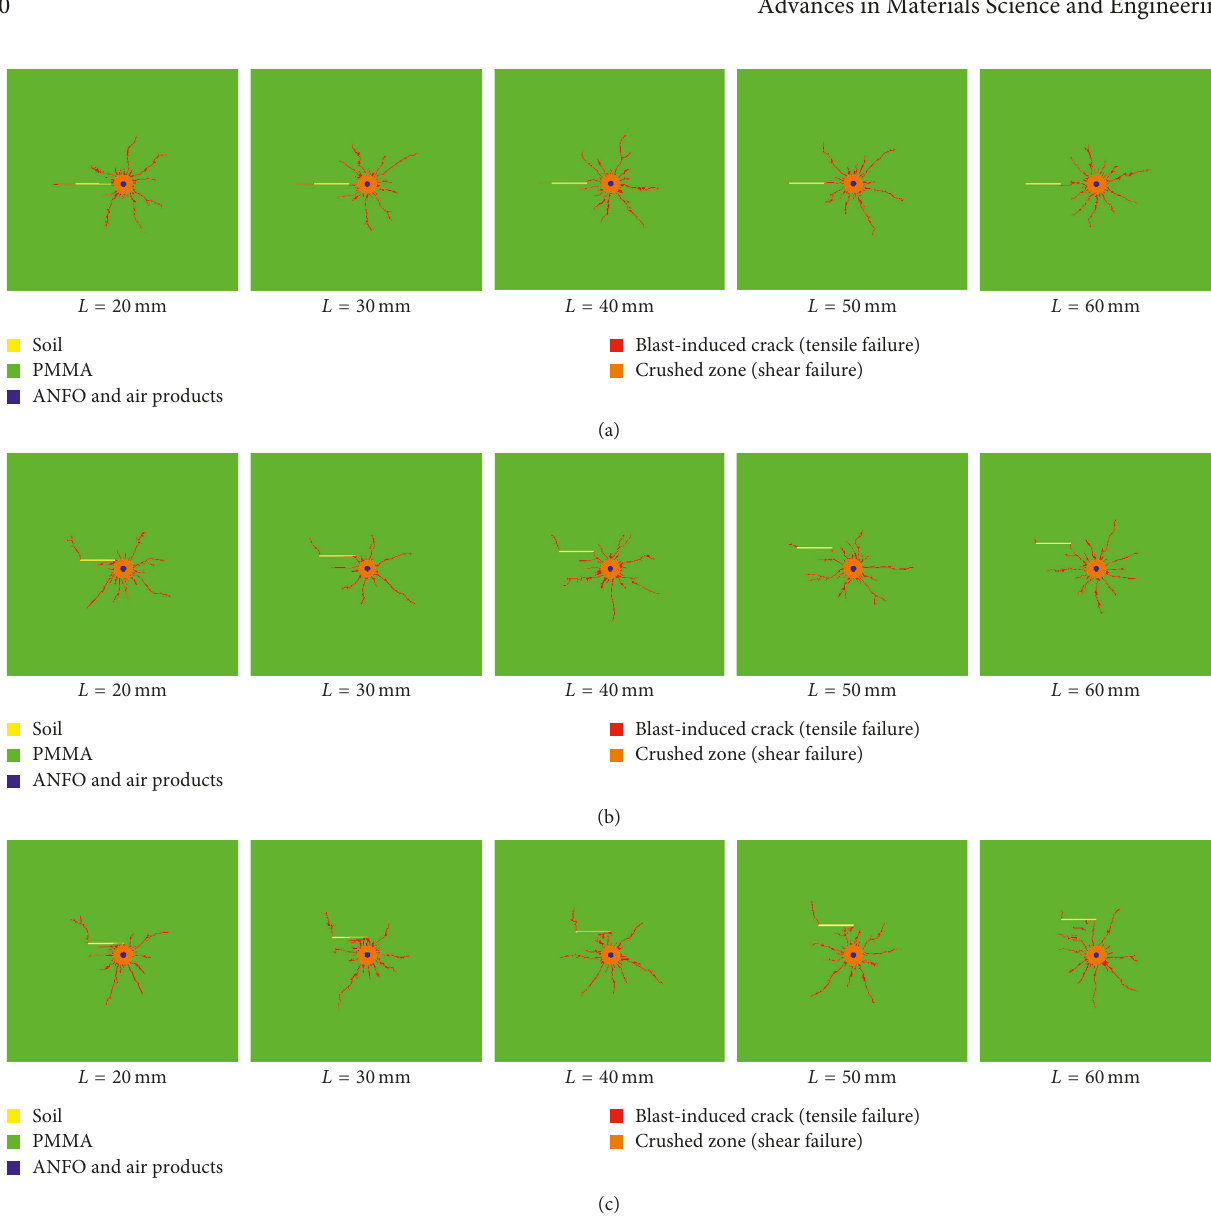
Figure 11: Material status of soil-filled PMMA after explosion. (a) θ � 0 ° ; (b) θ � 45 ° ; (c) θ � 90 °